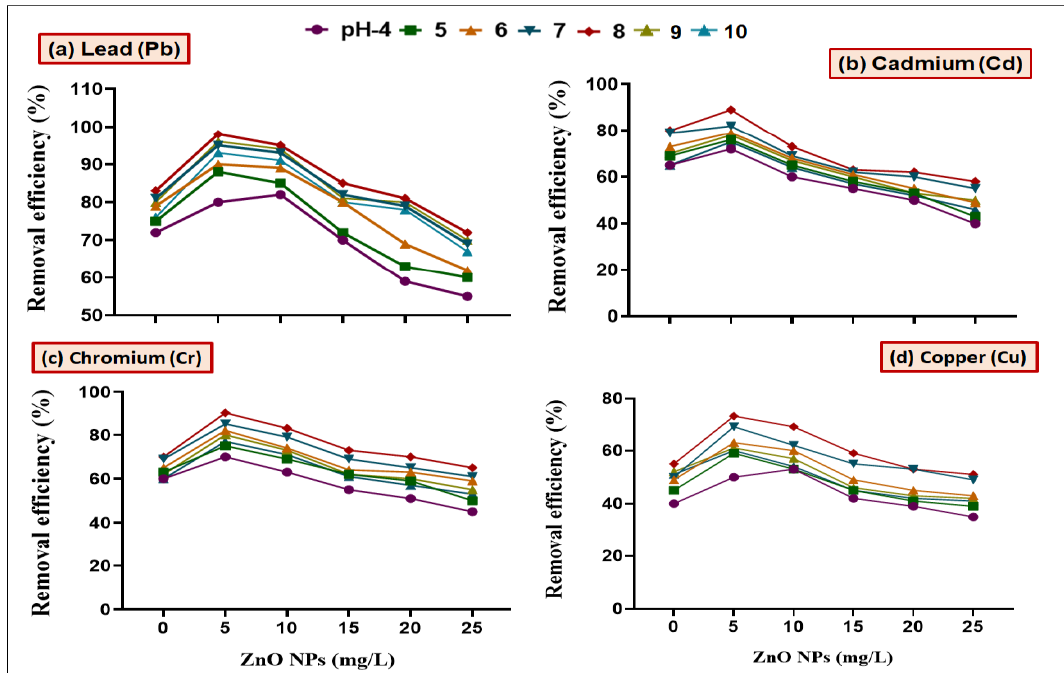
Figure 1. Synergistic effect of B. cereus and ZnO NPs (5, 10, 15, 20 and 25 mg/L) on the removal efficiency of ( a ) Lead (Pb), ( b ) Cadmium (Cd), ( c ) Chromium (Cr) and ( d ) Copper from the media amended with heavy metal at different pH (4, 5, 6, 7, 8, 9 and 10).